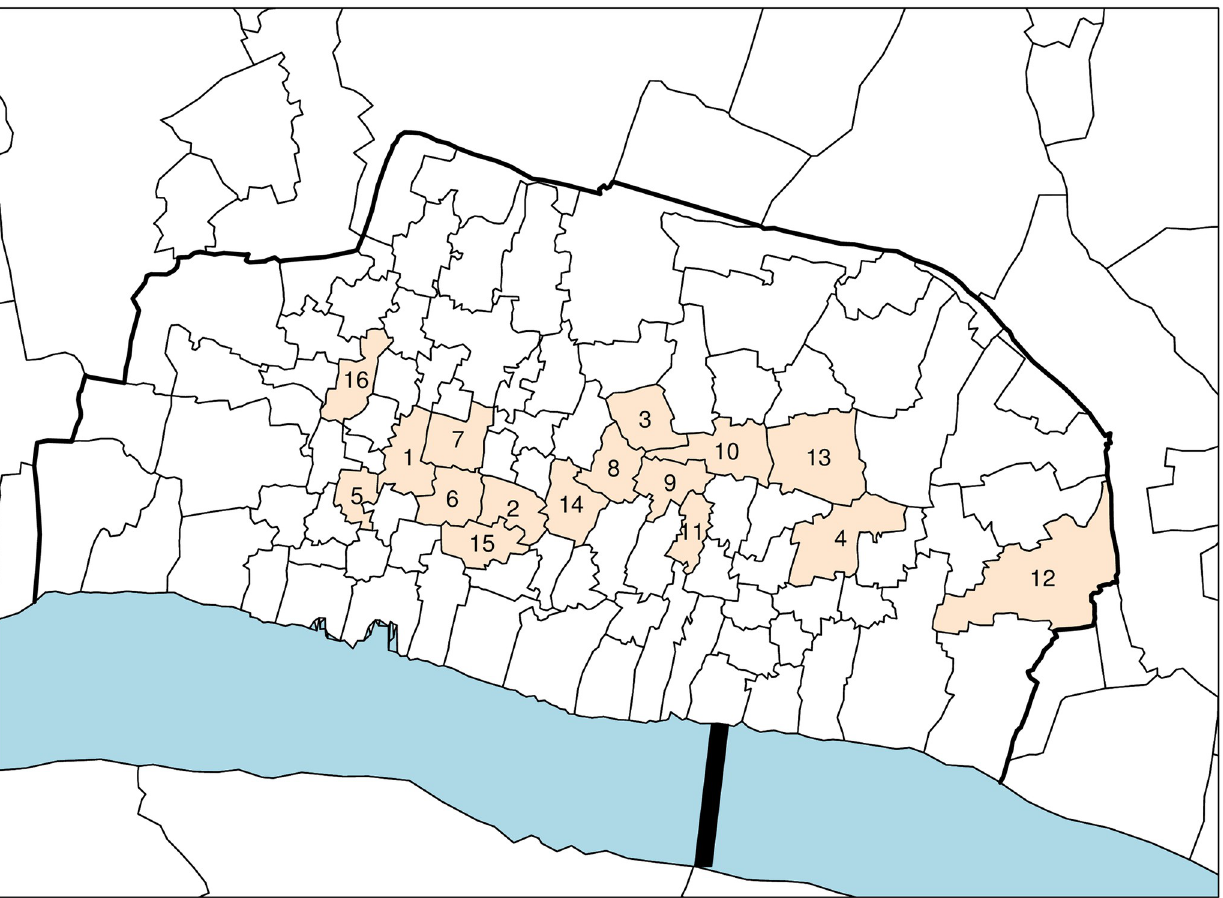
Fig 1. London ‘within-the walls’ to illustrate the location of the parishes selected for investigation. 1. All Hallows, Bread Street; 2. St. Antholin, Budge Row; 3. St. Christopher le Stocks; 4. St. Dionis Backchurch; 5. St. Margaret Moses; 6. St. Mary Aldermary; 7. St. Mary le Bowe; 8. St. Mary Woolnoth;